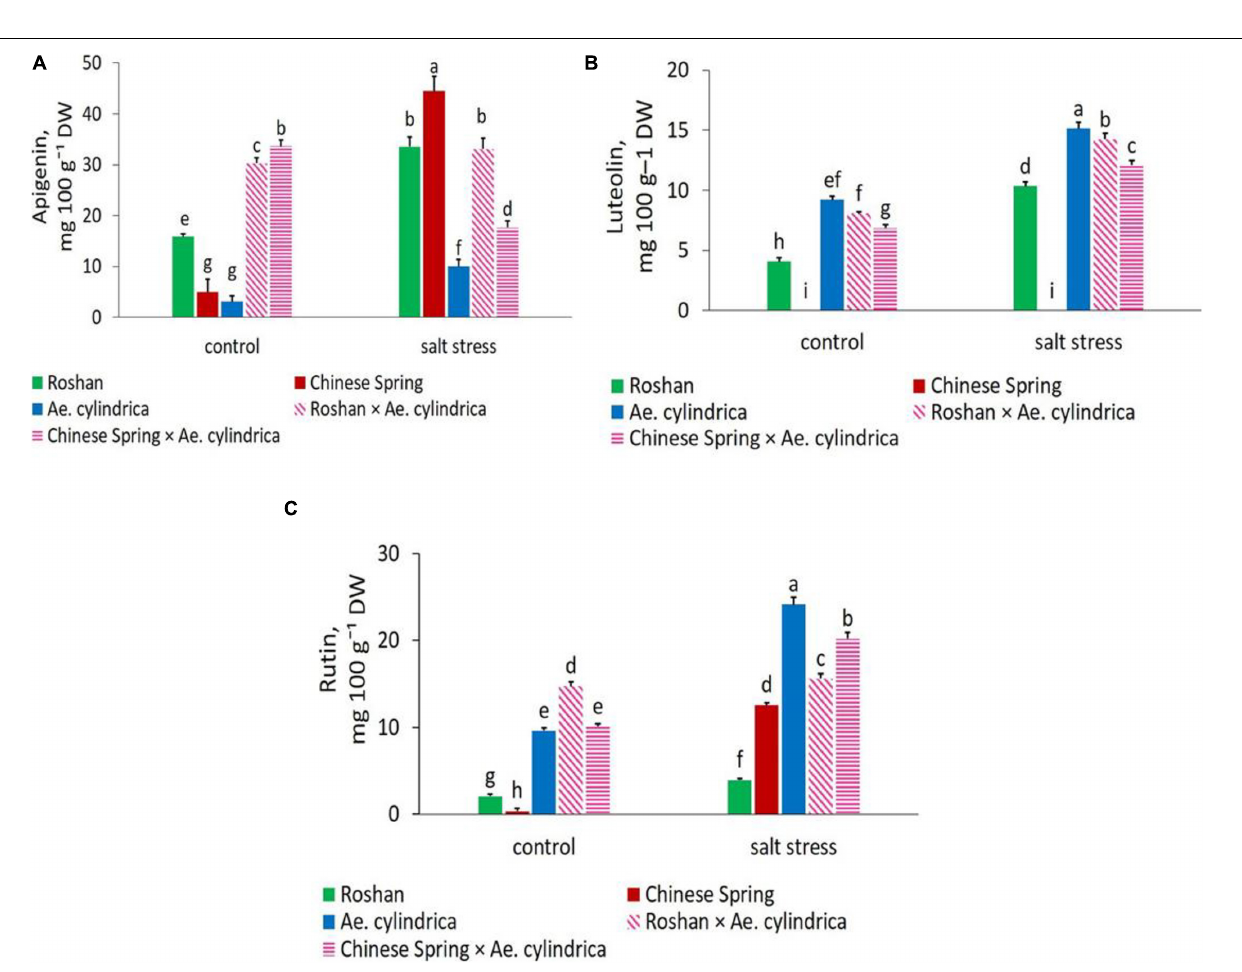
TABLE 5 | Results of multiple regression analysis with yield loss as a dependent variable under salt stress conditions.